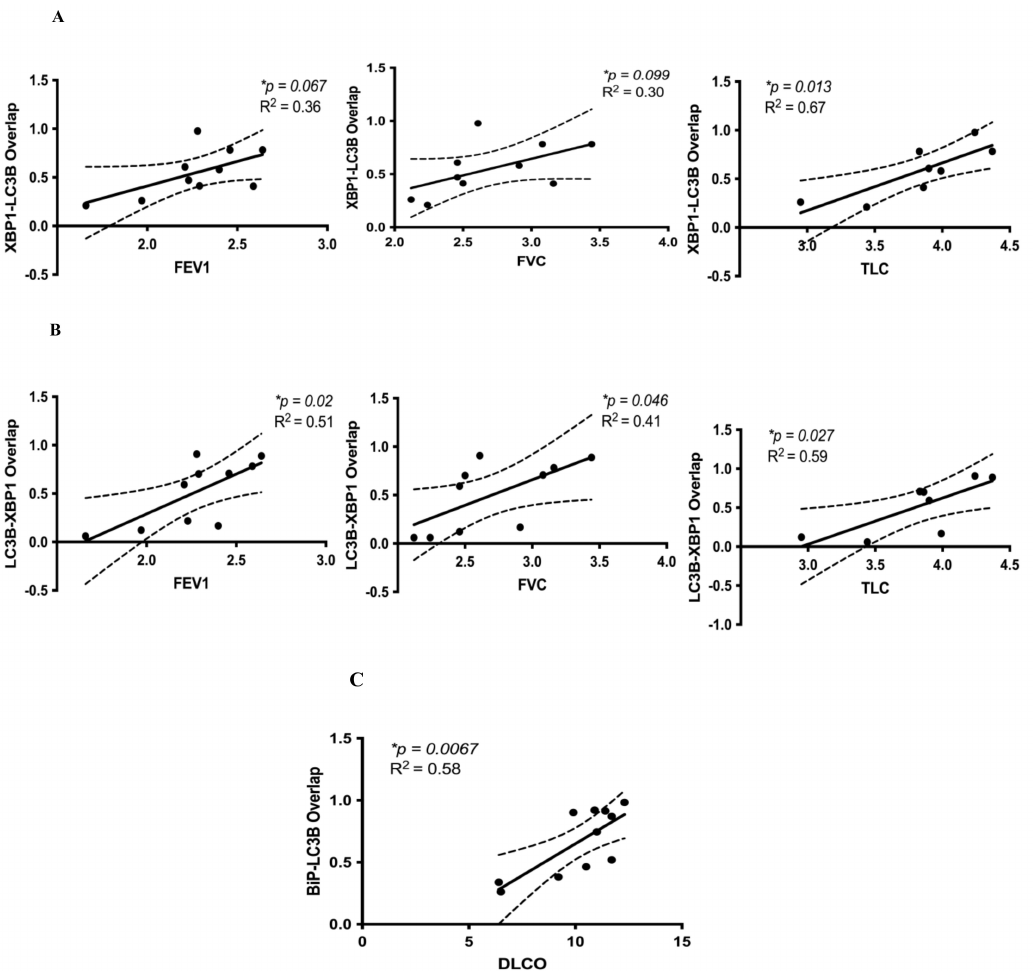
Figure 3. Correlations between co-localized UPR (XBP1, BiP) and autophagy (LC3 β puncta) markers and lung function in IPF. ( A ) Co-localized XBP1 and LC3 β puncta were positively correlated with FEV1 (* p = 0.067, R 2 = 0.36), FVC (* p = 0.099, R 2 = 0.30), and TLC (* p = 0.013, R 2 = 0.67). ( B ) Co-localized LC3 β puncta and XBP1 were positively correlated with FEV1 (* p = 0.02, R 2 = 0.51), FVC (* p = 0.046, R 2 = 0.41), and TLC (* p = 0.027, R 2 = 0.59). ( C ) Co-localized BiP and LC3 β puncta were positively correlated with DLCO (* p = 0.0067, R 2 = 0.58). Confidence intervals are included, shown by the dotted curved lines flanking the regression line. Linear regression analyses were performed using GraphPad Prism 9. Lung volumes (FEV1, FVC, TLC) were measured in liters, and the diffusion capacity of carbon monoxide (DLCO) was measured in